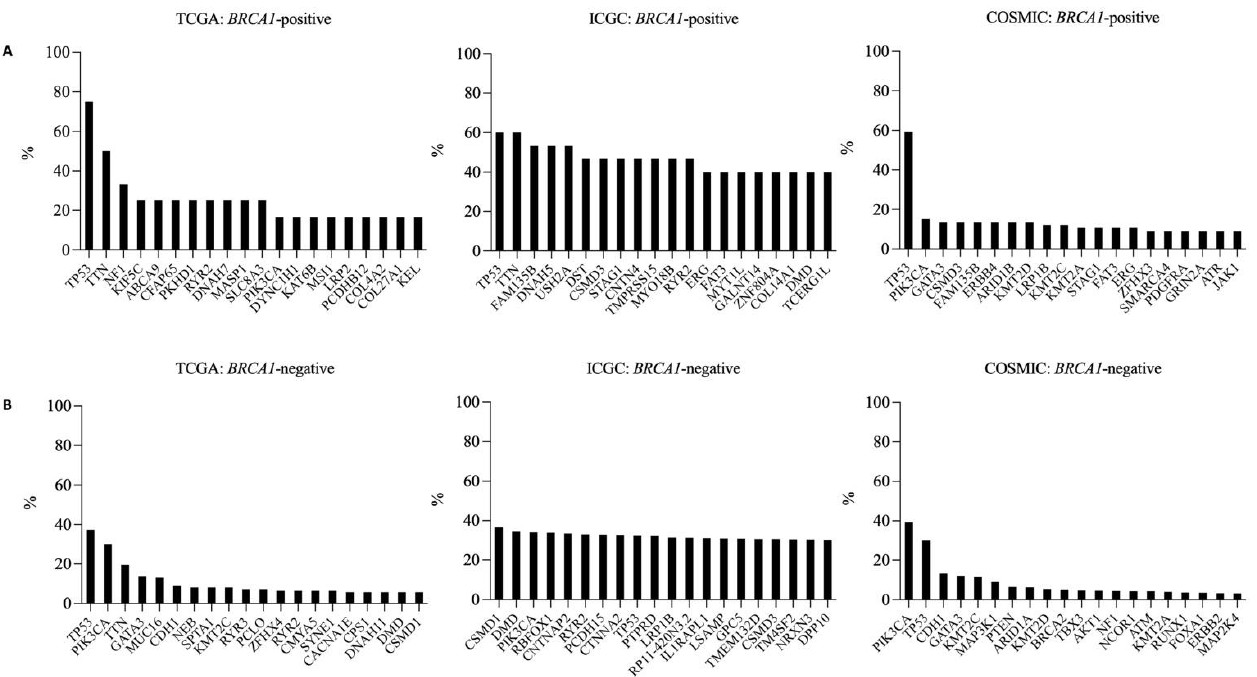
Figure 5. Top mutated genes in ( A ) BRCA1 -positive and ( B ) BRCA1 -negative breast cancer samples. X-axes indicate mutated genes and the Y-axes indicate the percentage of all samples with the corresponding mutated gene.